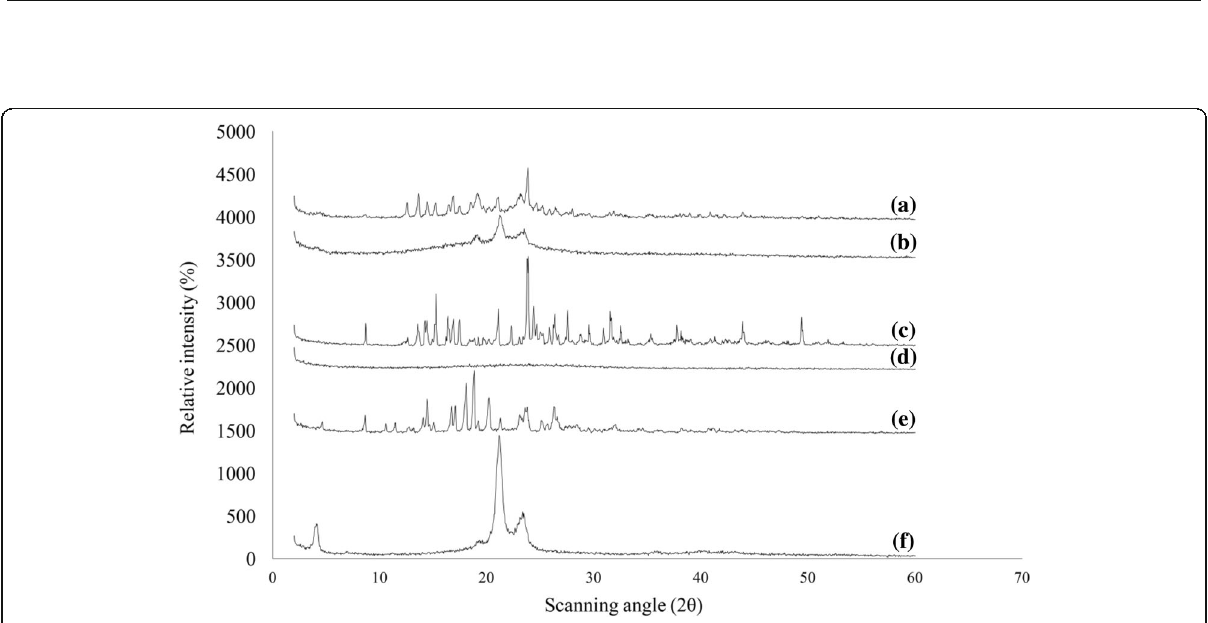
Fig. 9 X-ray patterns of a lyophilized HVD-NLCs formulation (VER-9), b lyophilized blank formulation, c trehalose, d dextran sulfate, e verapamil HCl, and f Compritol 888